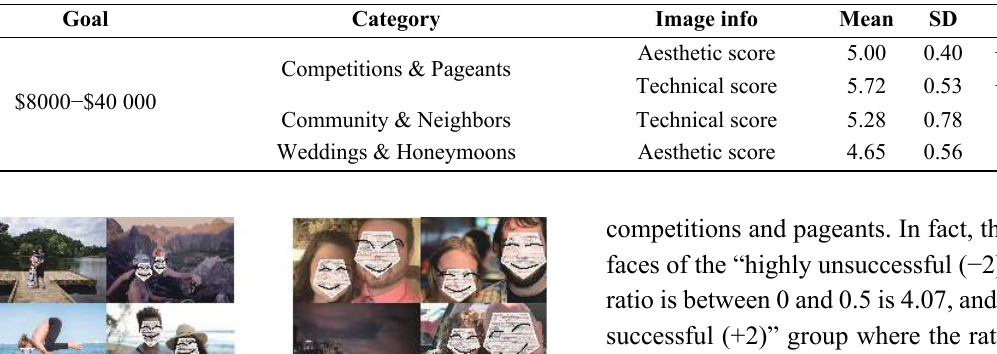
Table 3 Image quality features that have significant influences.